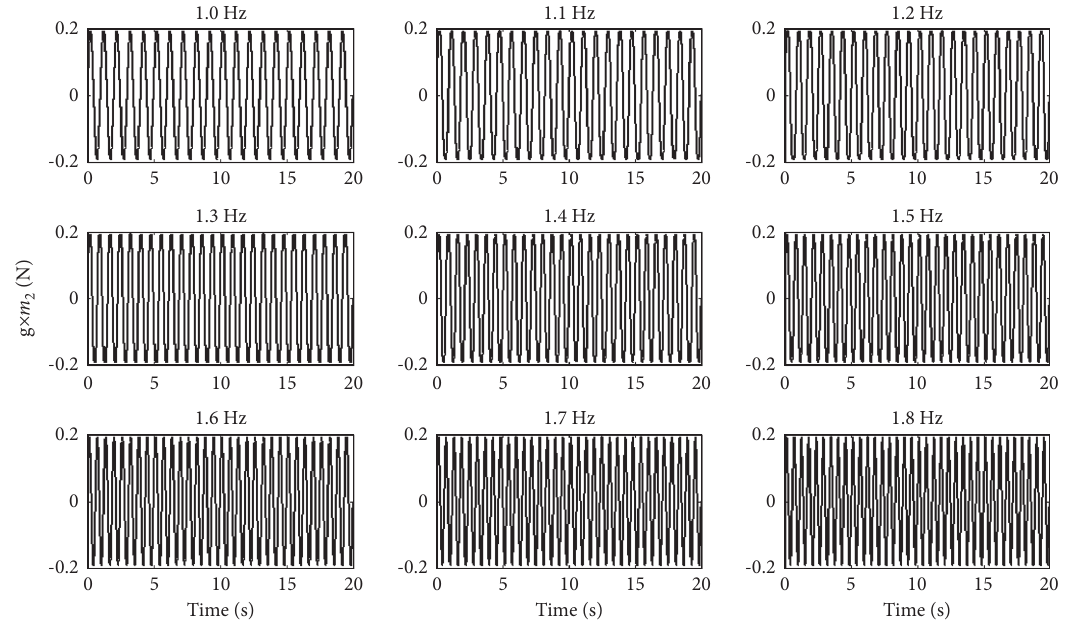
Figure 13: The simulated crowd swaying loads curves at nine frequencies.